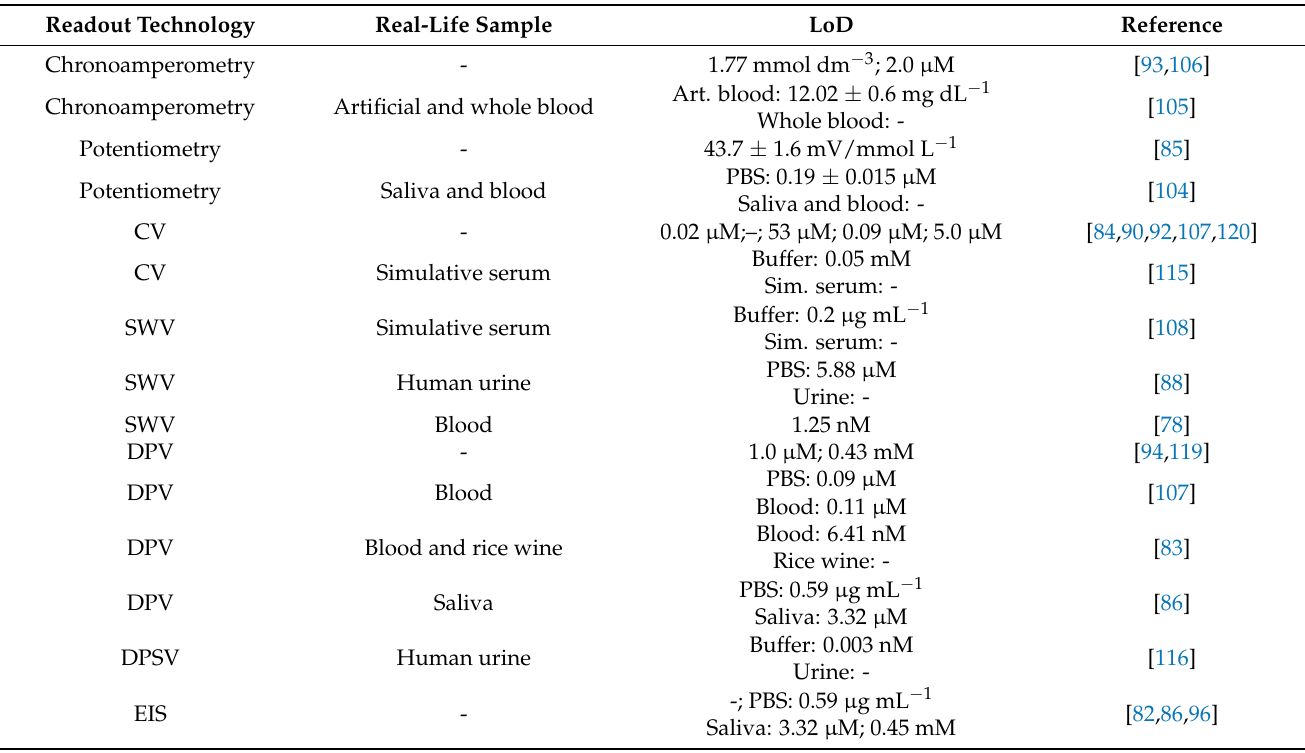
Table 2. MIP-based glucose sensors using electrochemical readout